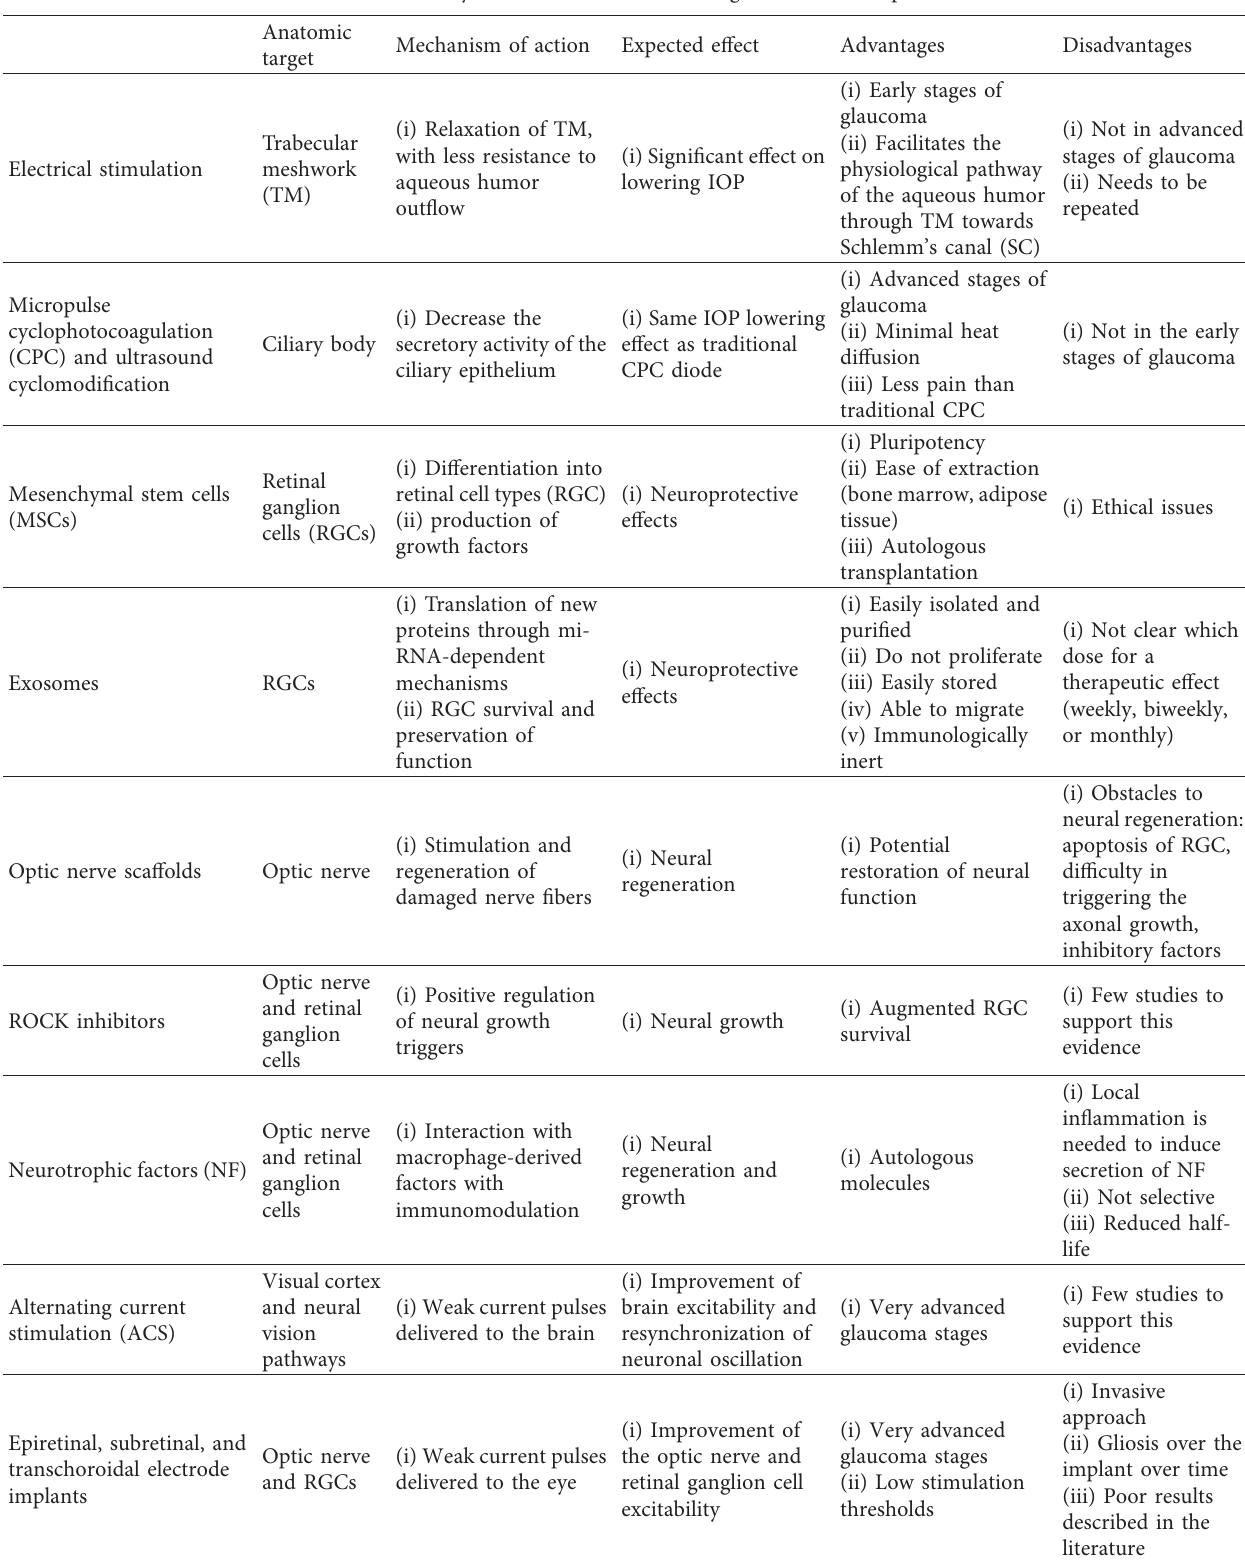
Table 1: Summary of the new treatment strategies under